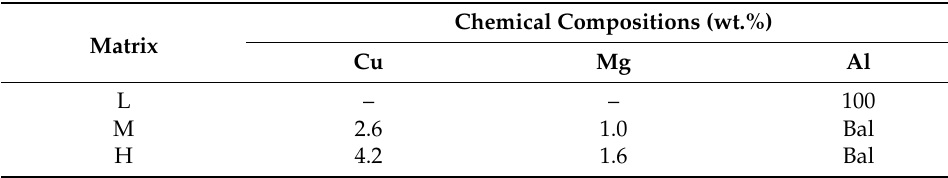
Table 2. Chemical compositions of the